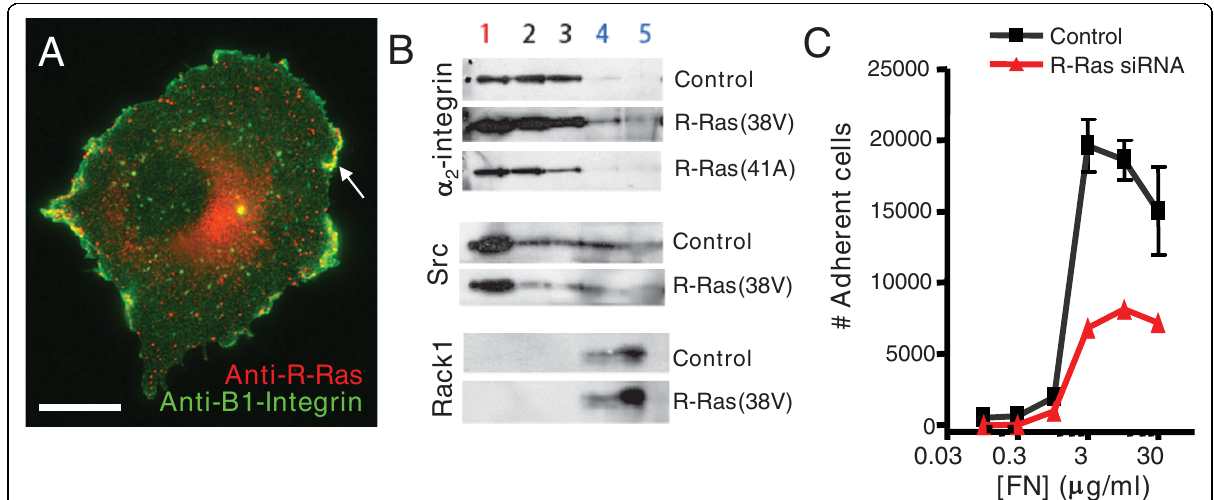
Figure 4 R-Ras regulates integrin localization in the plasma membrane . (A) Immunofluorescence of fixed Cos7 cells using antibodies against R-Ras and b 1 -integrin reveal colocalization of endogenous R-Ras and b 1 -integrin at ruffles. Scale bar = 20 μ m. (B) R-Ras activation enhances integrin localization to low-density lipid fractions. Lysates from T47D cells stably expressing R-Ras(38V), R-Ras(41A) or control (vector only) were fractionated on an Optiprep ™ gradient, and analyzed by subsequent SDS-PAGE and immunoblotting. Activated R-Ras increased the amount of b 1 -integrin (determined by antibody to the a 2 subunit) at the plasma membrane, specifically in the low-density microdomain that contains Src, which itself was not increased in this membrane fraction by activation of R-Ras. Integrin was not found in the bulk plasma membrane, identified by Rack1. (C) Cos7 cell adhesion on increasing fibronectin (FN) concentrations was reduced following the transfection of 20 nM siRNA directed against